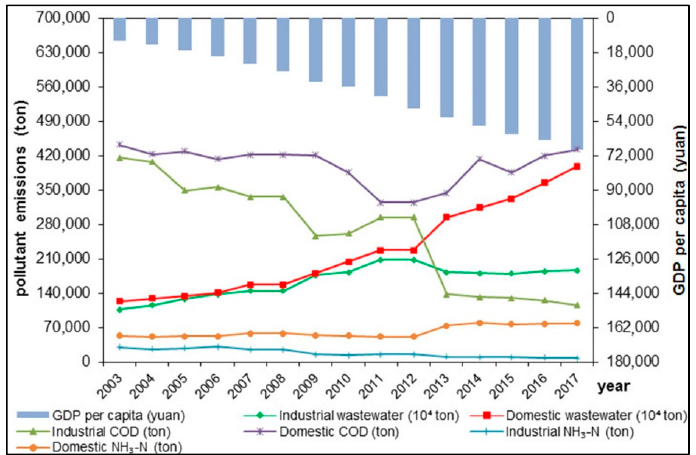
Figure 3. Indicators of water pollution and socio-economic development in Shandong from 2003 to